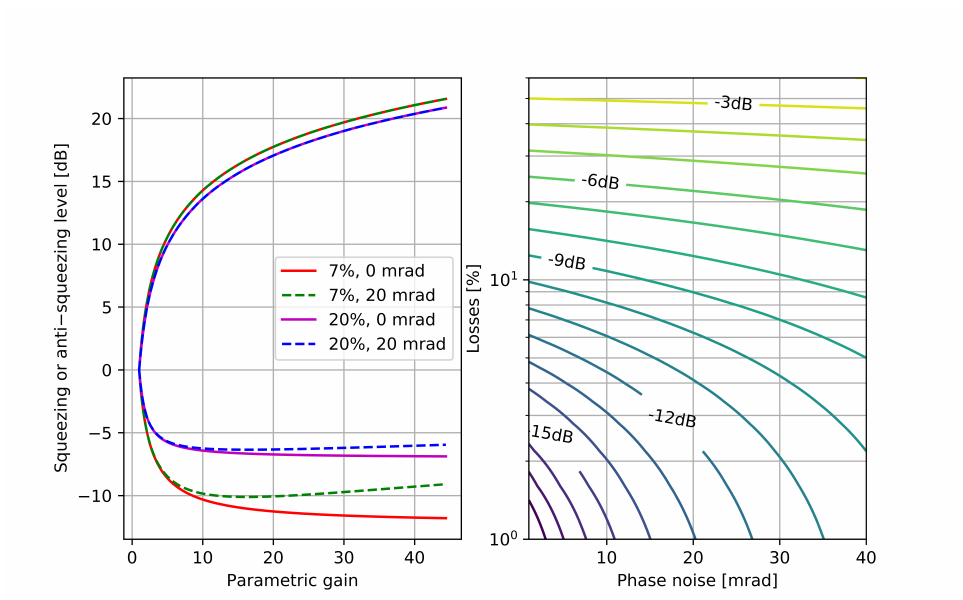
Figure 6. ( Left ) Levels of loss and phase noise in a squeezing measurement can be characterized by measuring the level of squeezing as the parametric gain is varied by changing the OPO pump power. Expressions used to make this plot are explained in [55,56]. The 20% and 7% loss levels are expected requirements for reaching 6 dB and 10 dB of observed squeezing in current and future interferometers. ( Right ) Observable squeezing level with parametric gain optimized for high squeezing [48,52]. This figure shows that to improve from 3 dB to 6 dB of squeezing requires mostly loss reduction, but to reach the 10 dB level of squeezing will also require low phase